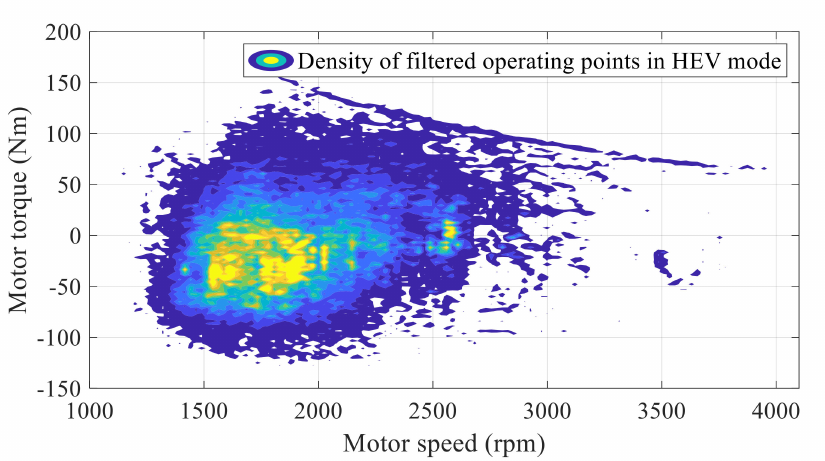
Figure 17. Density of Operating Points of the